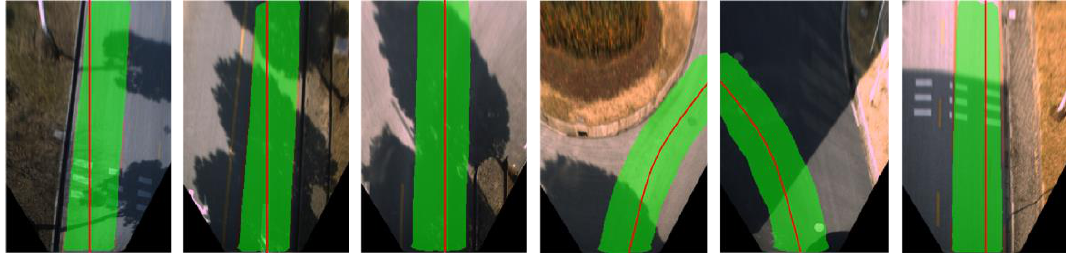
Table 2. Average detection accuracy. Approach